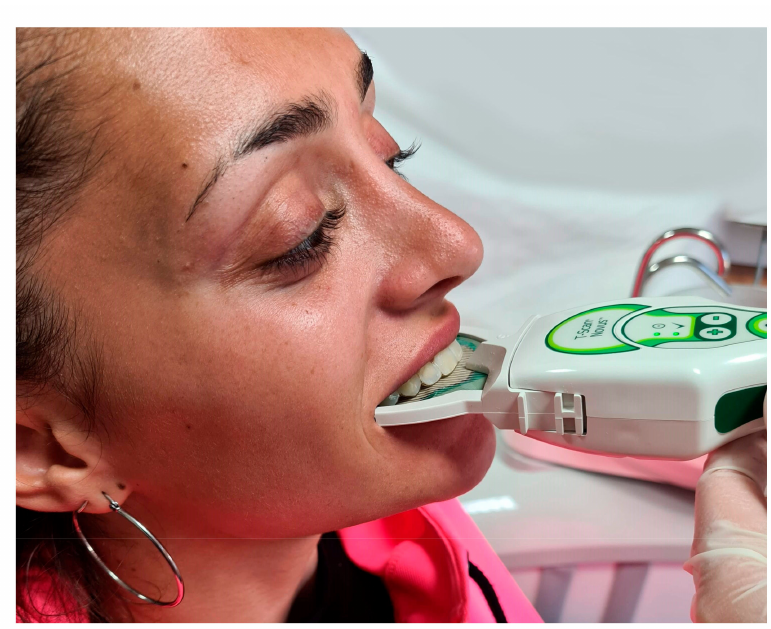
Figure 1. Positioning the T-Scan device in the patient’s